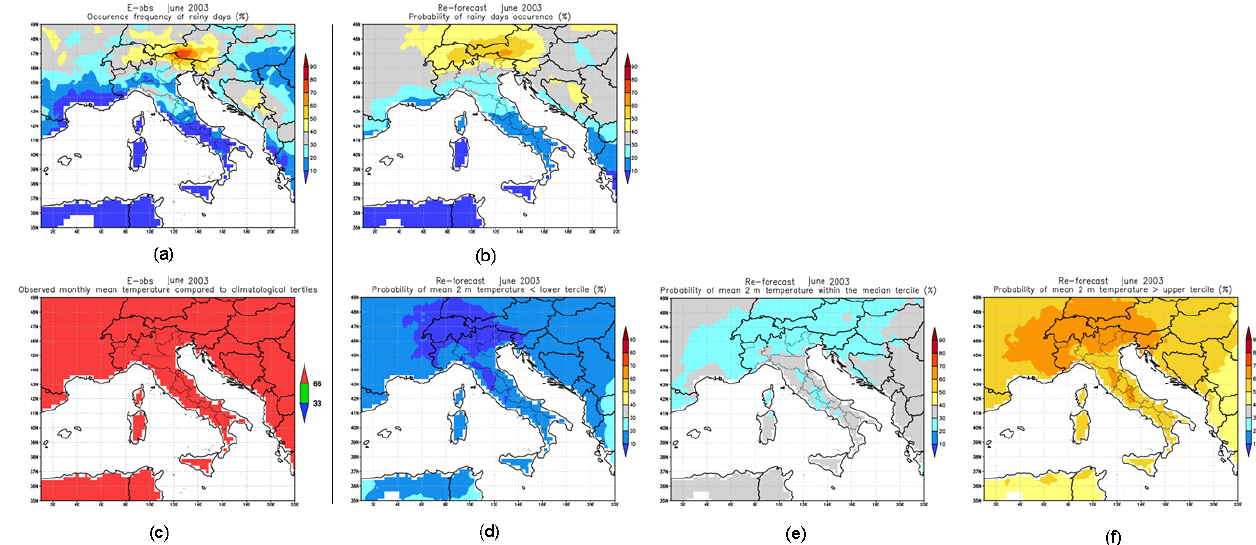
Figure 3. June 2003: observations E-OBS versus the operational chain re-forecast: the E-OBS occurrence frequency of rainy days (a) , the re-forecast probability of the rainy days occurrence (b) , the E-OBS tertile climatological distribution (c) , the re-forecast probability to stay below the lower tertile (d) , the re-forecast probability to stay within the median tertile (e) and the re-forecast probability to stay above the upper tertile (f)